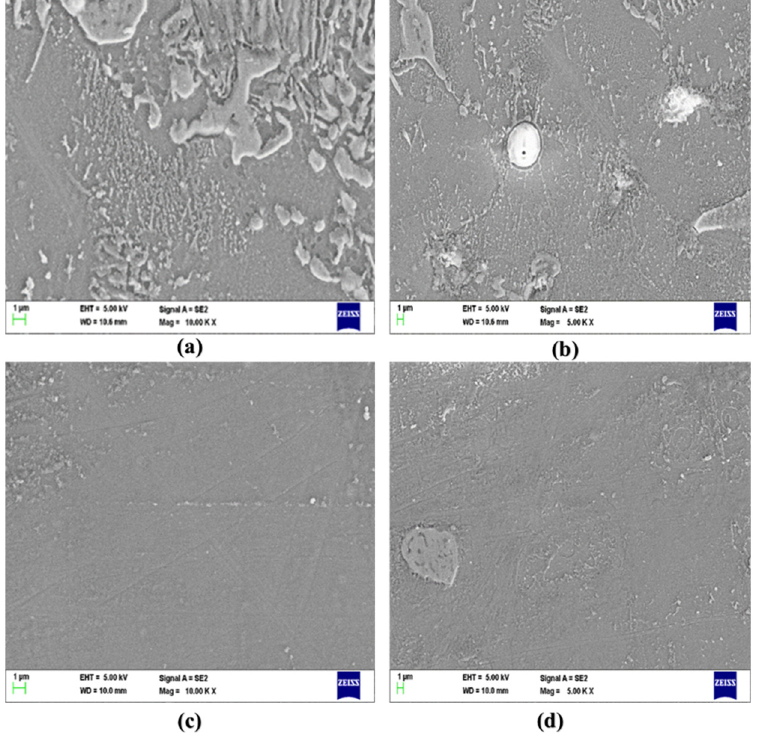
Figure 3. SEM micrographs of AZ91D composite with varying weight percentages of CF and MWCNT reinforcements. ( a , b ): AZ91D + 0.5% CF’s + 0.5% MWCNT composite and ( c , d ): AZ91D + 0.75% CF’s + 0.75% MWCNT composite.